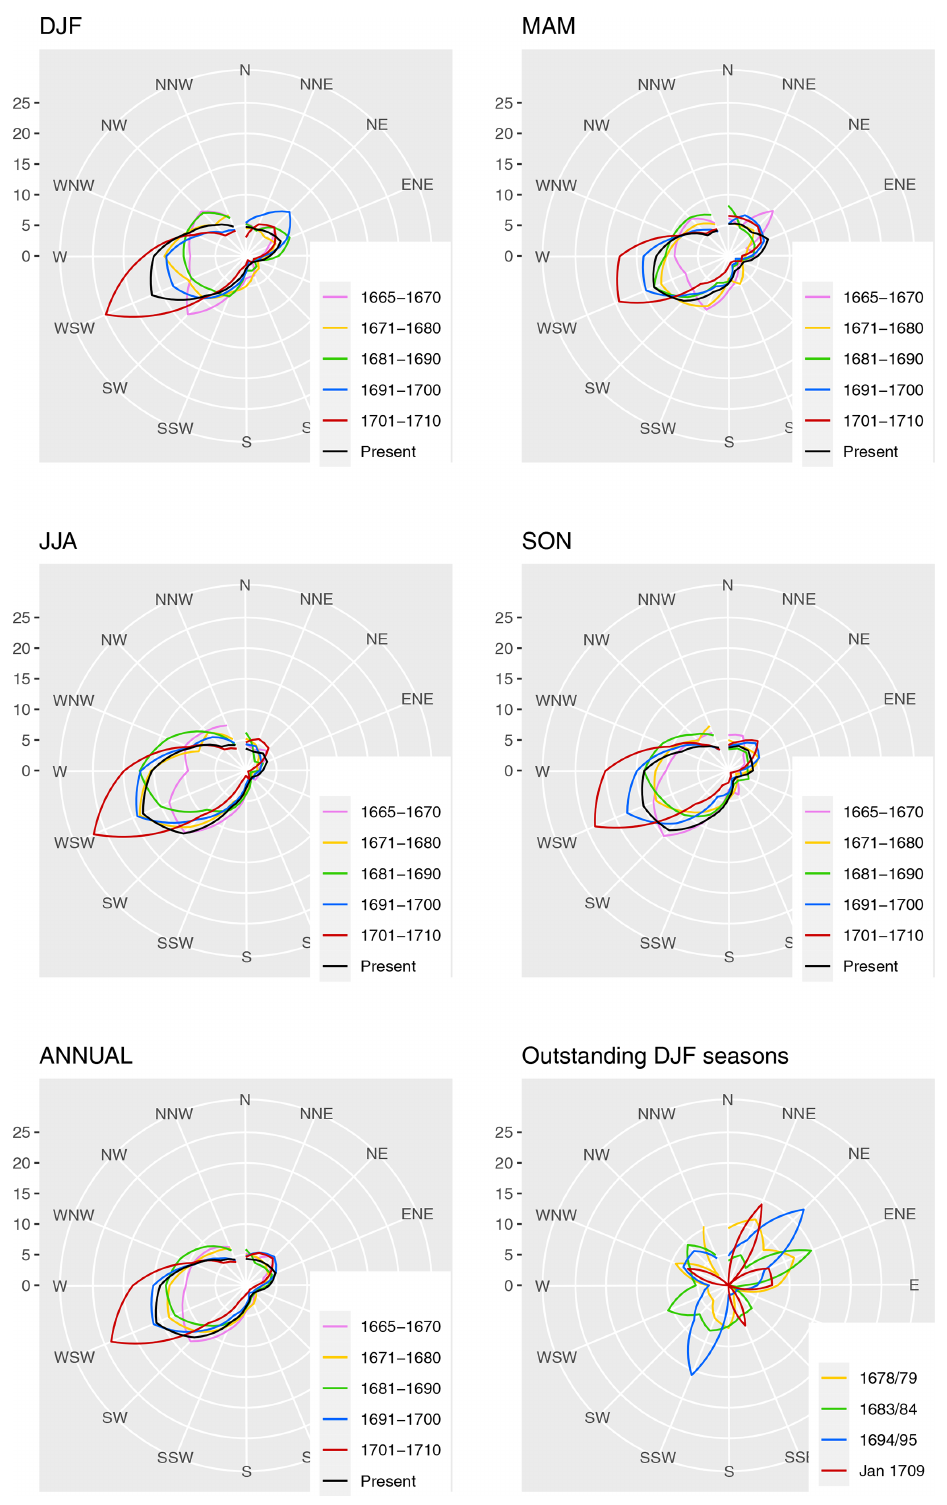
Figure 11. Visualization of DIs (in percentage of total days) as a seasonal mean (DJF, MAM, JJA, SON), as an annual mean, for outstanding DJF seasons, and for January